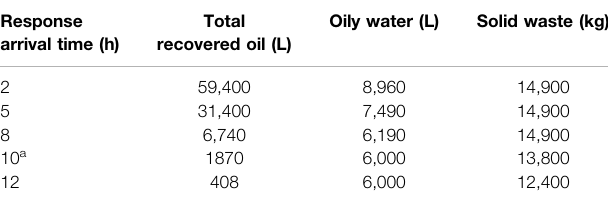
TABLE4| Sensitivityanalysisoftheeffectofresponsearrivaltimeonrecoveredoil, oily water, and solid waste. Response arrival time (h)